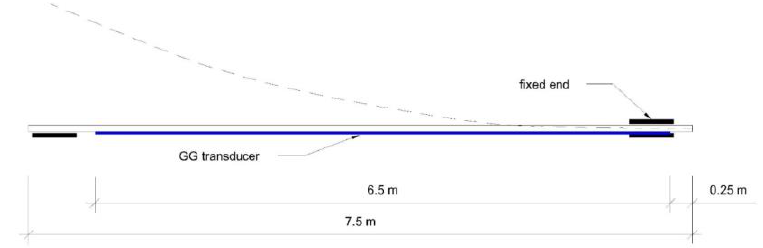
Figure 6. Second test: Structural scheme.